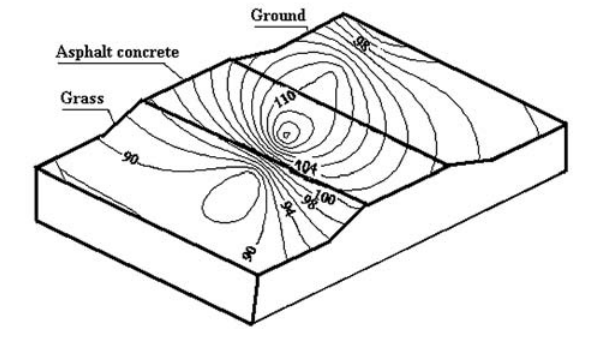
Fig. 2. Distribution of values of EDR above some different